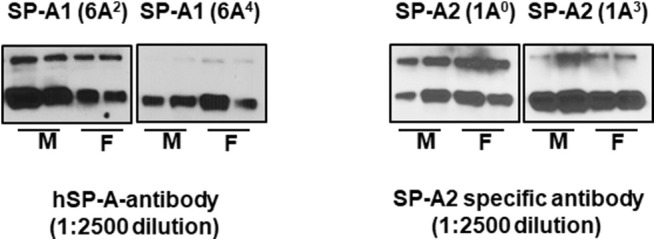
The expression levels of SP-A variants in BAL of males (M) and females (F) were monitored by western blot analysis. The hSP-A antibody (1:2500 dilution) recognizes both SP-A1 and SP-A2 proteins, whereas, the SP-A2 antibody (Aviva-ARP64034_P050, 1-2500 dilution) is specific to SP-A2 protein (no such antibody is available for SP-A1) and does not recognize SP-A1 proteins.